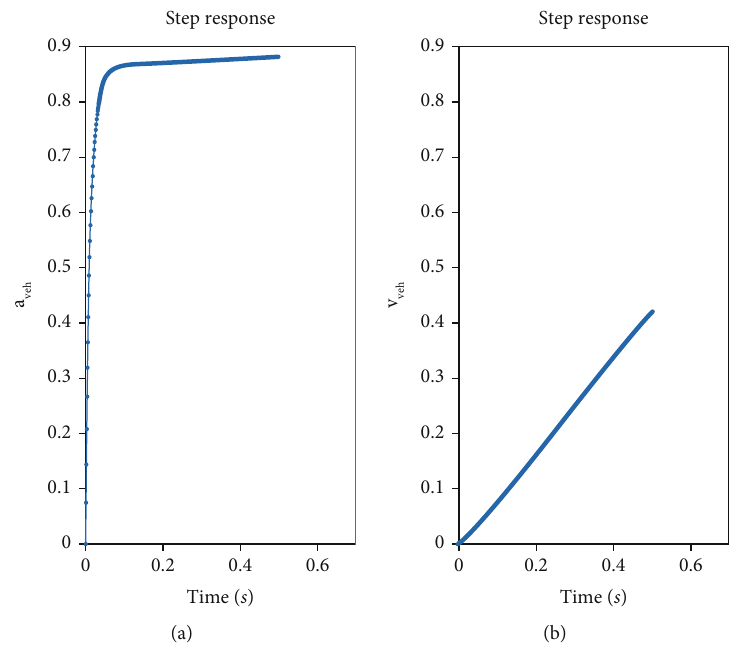
Figure 6: Vehicle acceleration (a) and speed (b) responses, respectively, in PI (3).